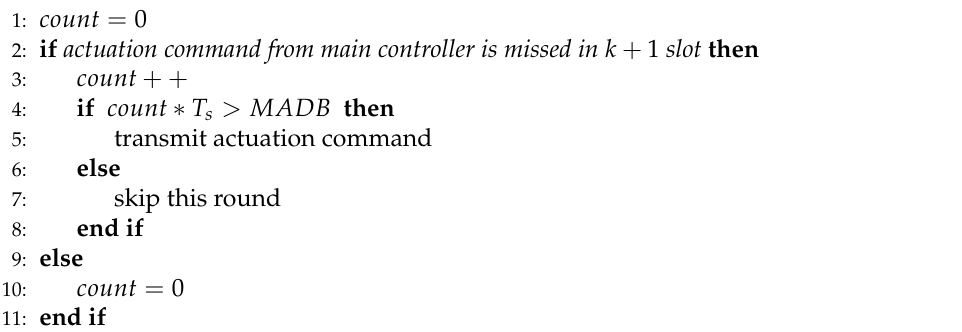
Algorithm 1 Pseudocode of switching algorithm in backup